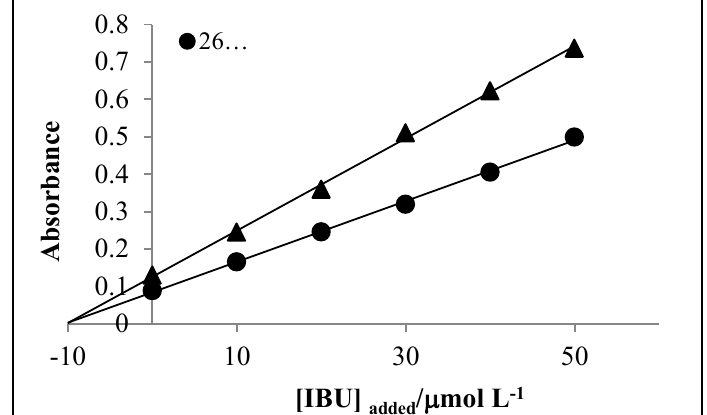
Figure 4: H-point standard addition plot constructed at wavelength pair of 226 and 260 nm. Conditions: B-R buffer (pH 11.0), PAR (10 µmol L -1 ), IBU (10 µmol L -1 ) and caffeine (10 µmol L -1